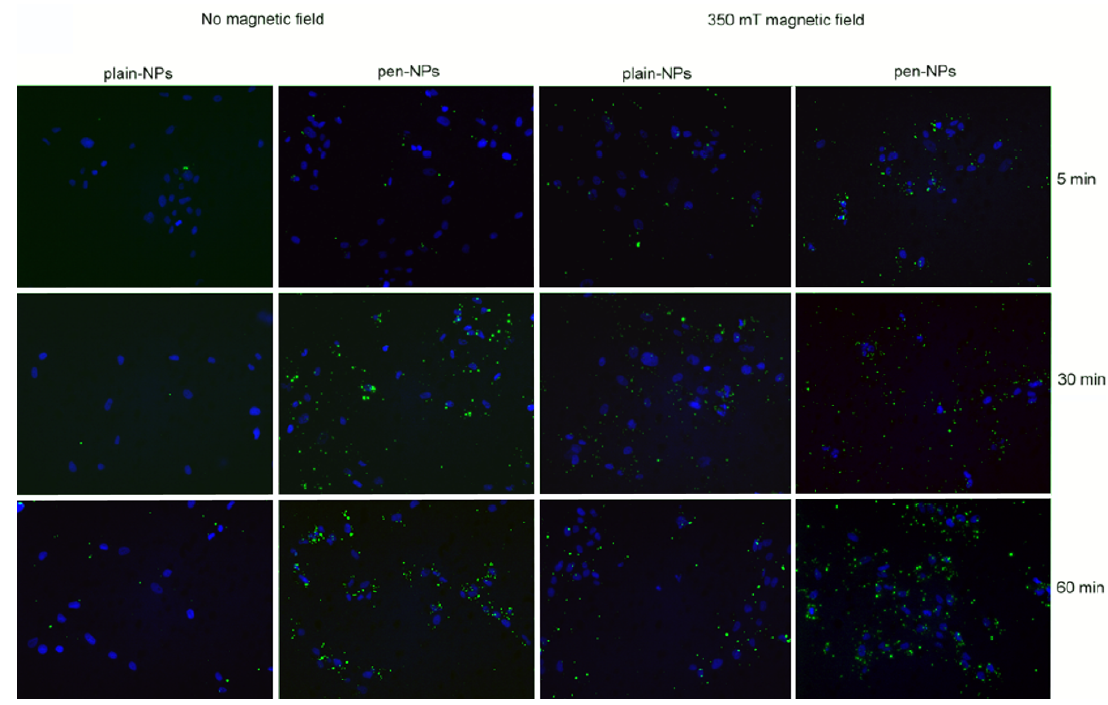
plain and penetratin NPs +/- magnetic field (MF) over a 60 minute incubation period for the 200 nm NPs (green: NPs, blue: